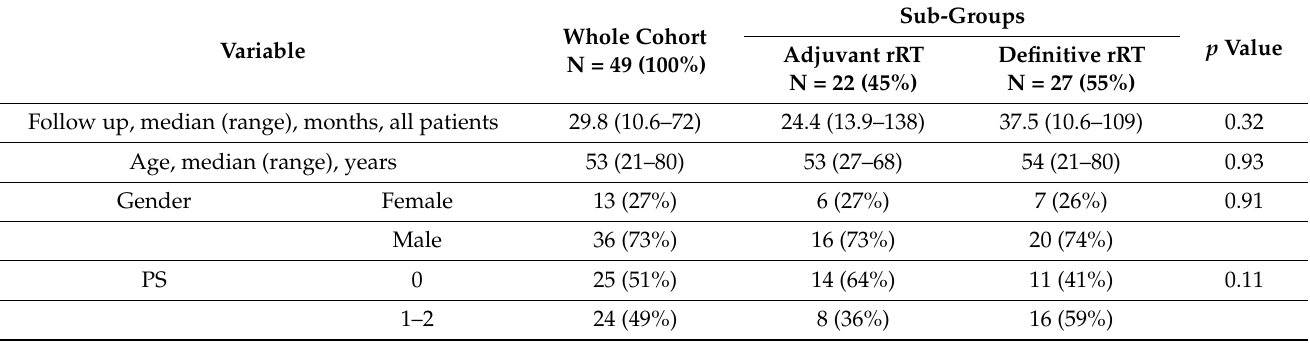
Table 1. Patients, tumor, and treatment